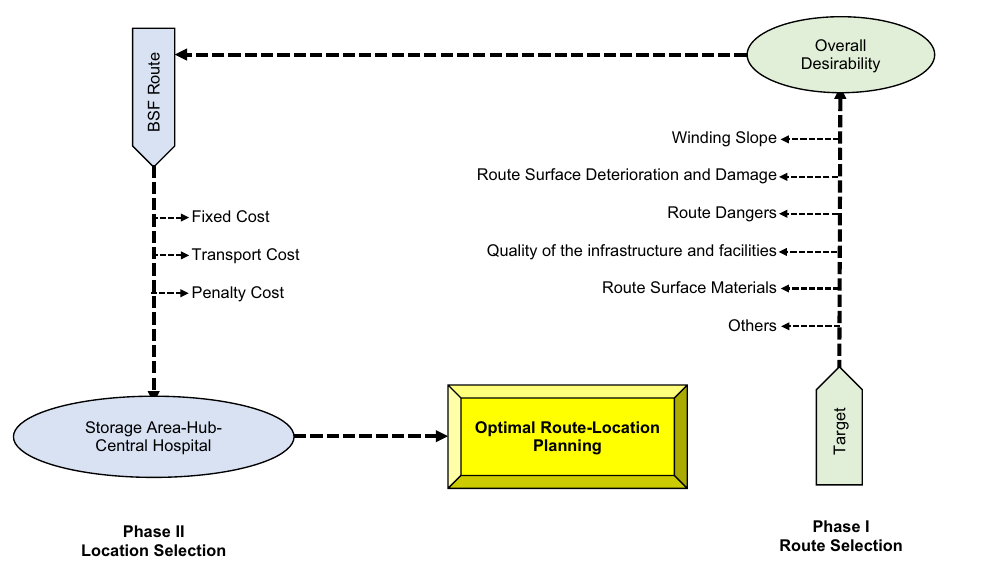
Figure 2. Diagram of two-stage zero-one programming